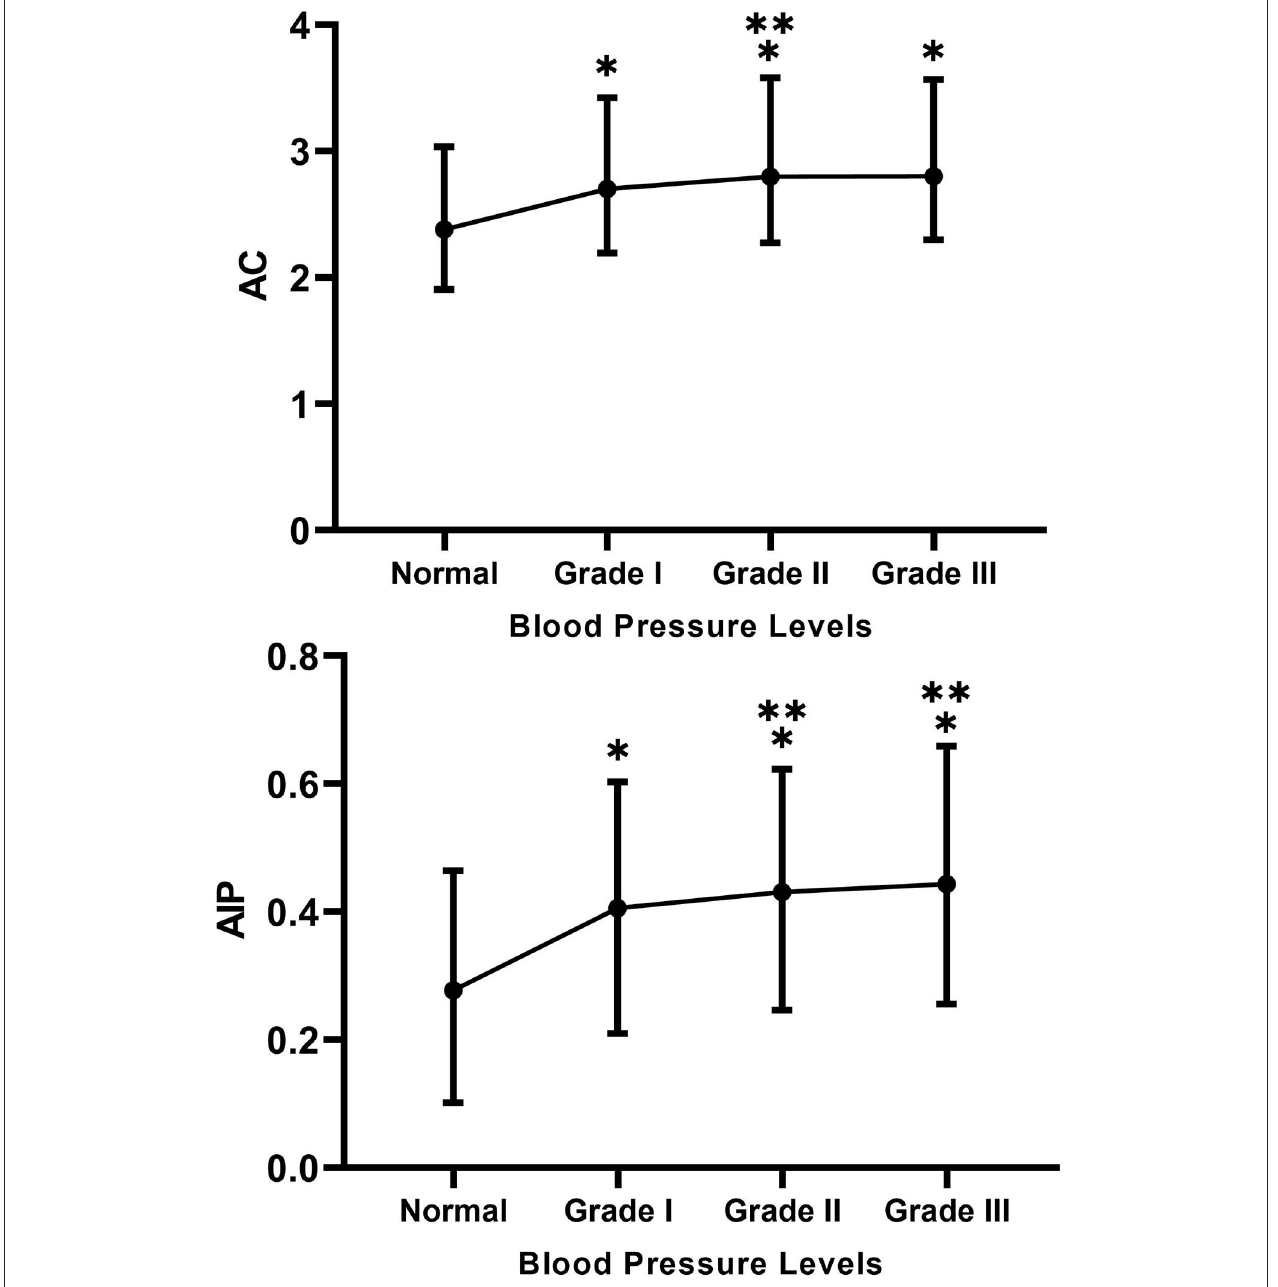
FIGURE 3 | Between-group differences in atherogenic coefficient (AC) and atherogenic risk of plasma (AIP) at different blood pressure levels. * Indicates Grades I–III compared with the normal group with p < 0.05. ** Indicates Grades II and III compared with Grade I with p < 0.05.